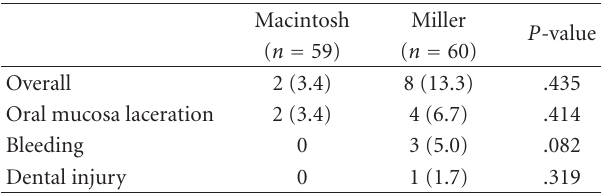
Table 4: Procedure related complications during and immediately after tracheal intubation ( n , %). Macintosh Miller P - value ( n = 59) ( n = 60) Overall 2 (3.4) 8 (13.3) .435 Oral mucosa laceration 2 (3.4) 4 (6.7) .414 Bleeding 0 3 (5.0) .082 Dental injury 0 1 (1.7) .319 ∗ Considered to be of statistical